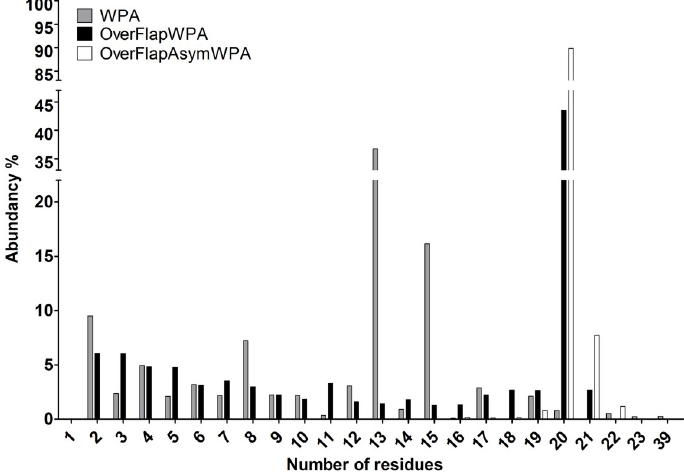
Fig 7. Quantification of randomized region encoded peptides according to size. As the Materials and methods section describe, in addition to randomized region the data also includes the last aa of the α -factor secretion signal CDS and stop codon. In the case of ‘1’, last aa of α -factor secretion signal CDS was missing.